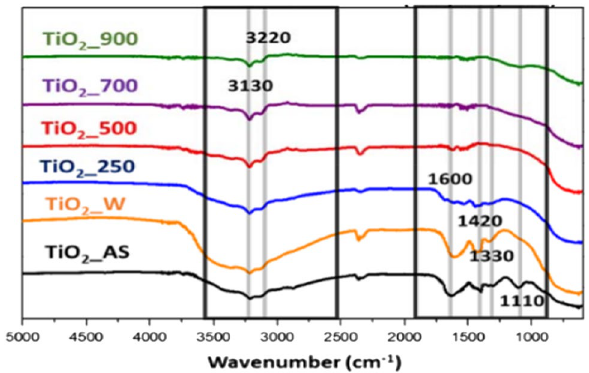
Fig. 14 FTIR spectra of TiO 2 nanoparticles calcined at 250–900 °C (Fernández-Catalá et al. 2017)